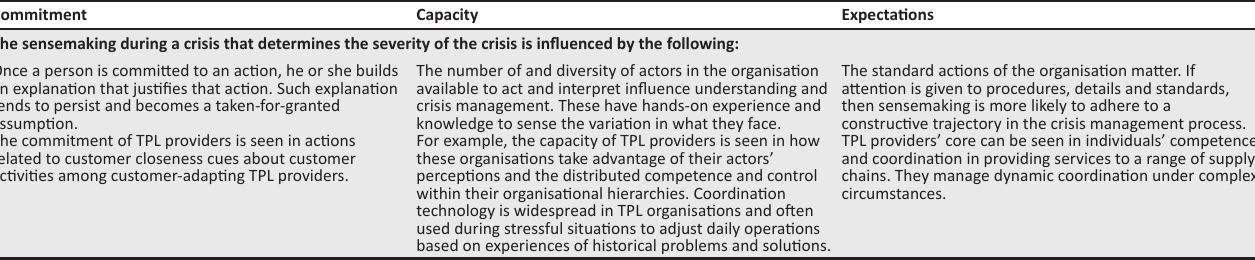
TABLE 1: Analysing third-party logistics sensemaking processes. Commitment Capacity